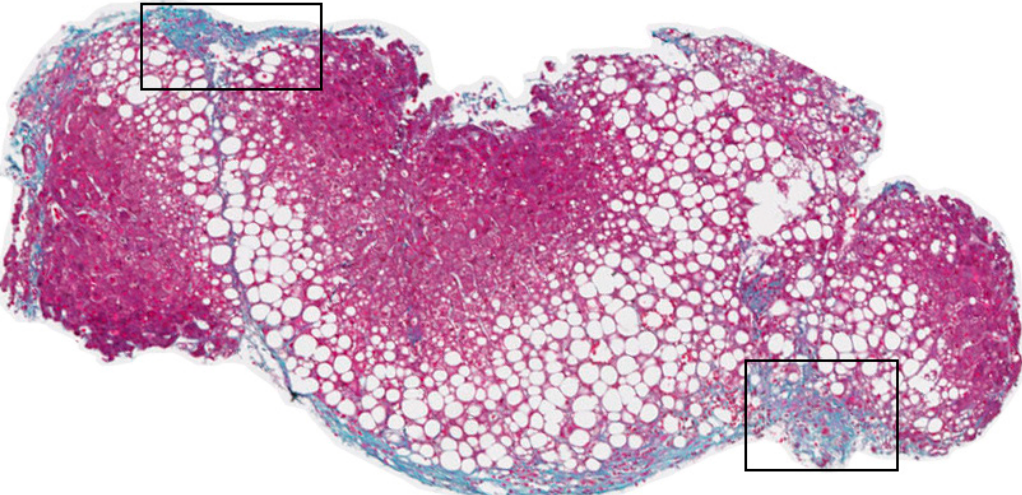
Figure 6. Masson’s trichrome stained biopsy specimen, carrying a magnification factor of ×40 and showing thin and broad (bounding boxes) fibrous septa in end-stage cirrhosis.